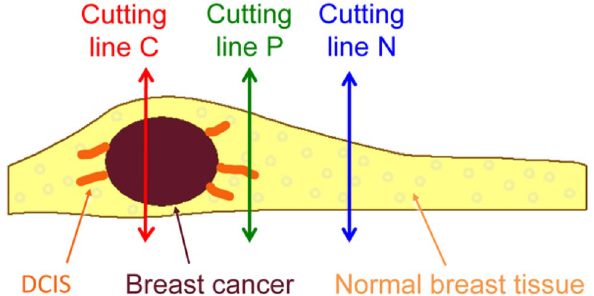
Figure 6. Sampling sites of the resected mammary specimens. Three samples were obtained from the surgically resected tissues. The central portion of the cancerous mass (cutting line C), a peripheral region that potentially contained non-invasive cancer cells (cutting line P), and a normal mammary tissue distant from the cancerous lesion (cutting line N) were surgically